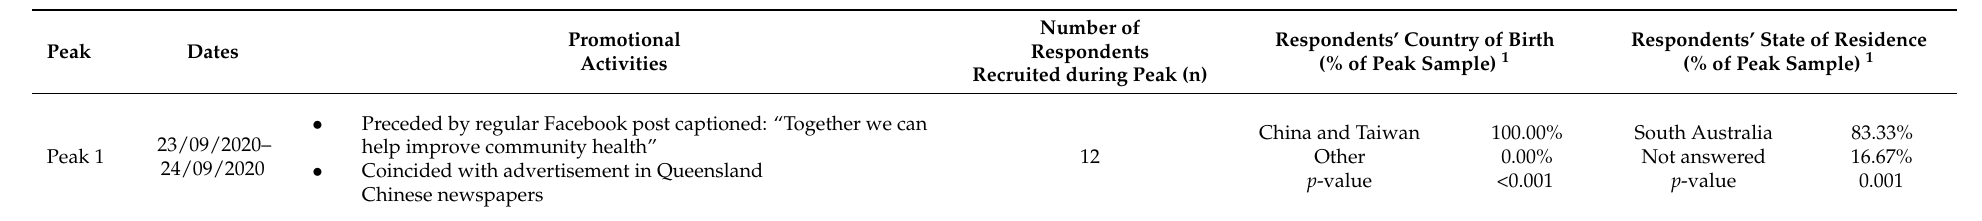
Figure 2. Number of daily respondents to the online survey (referred via Facebook or mibss.org) mapped against date and method of promotion. Table 5. Recruitment peaks for referrals from Facebook and mibss.org according to date, associated promotional activities, and respondent characteristics.